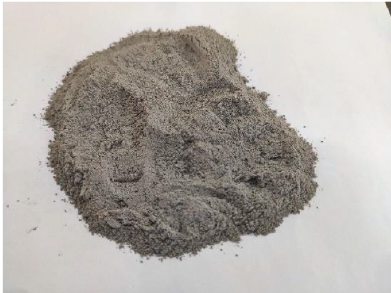
Figure 1: The macroscopic morphology of lunar soil